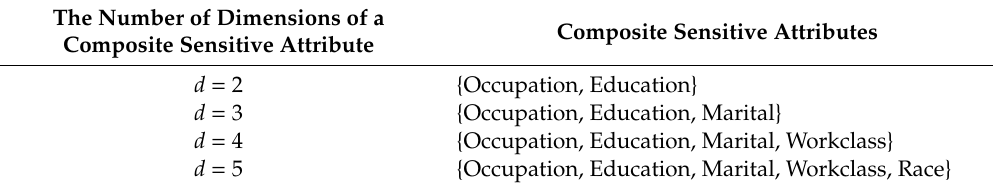
Table 4. Di ff erent composite sensitive attributes for the multiple sensitive attributes of the